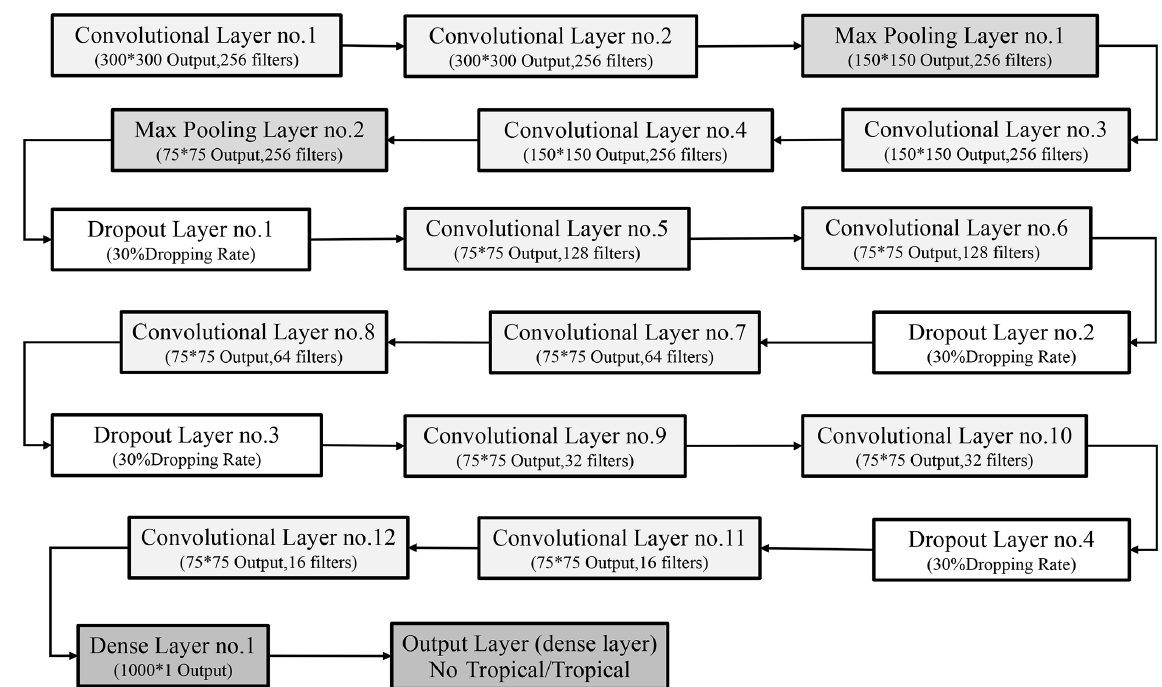
Figure 3. Detailed structure of the proposed DCNN